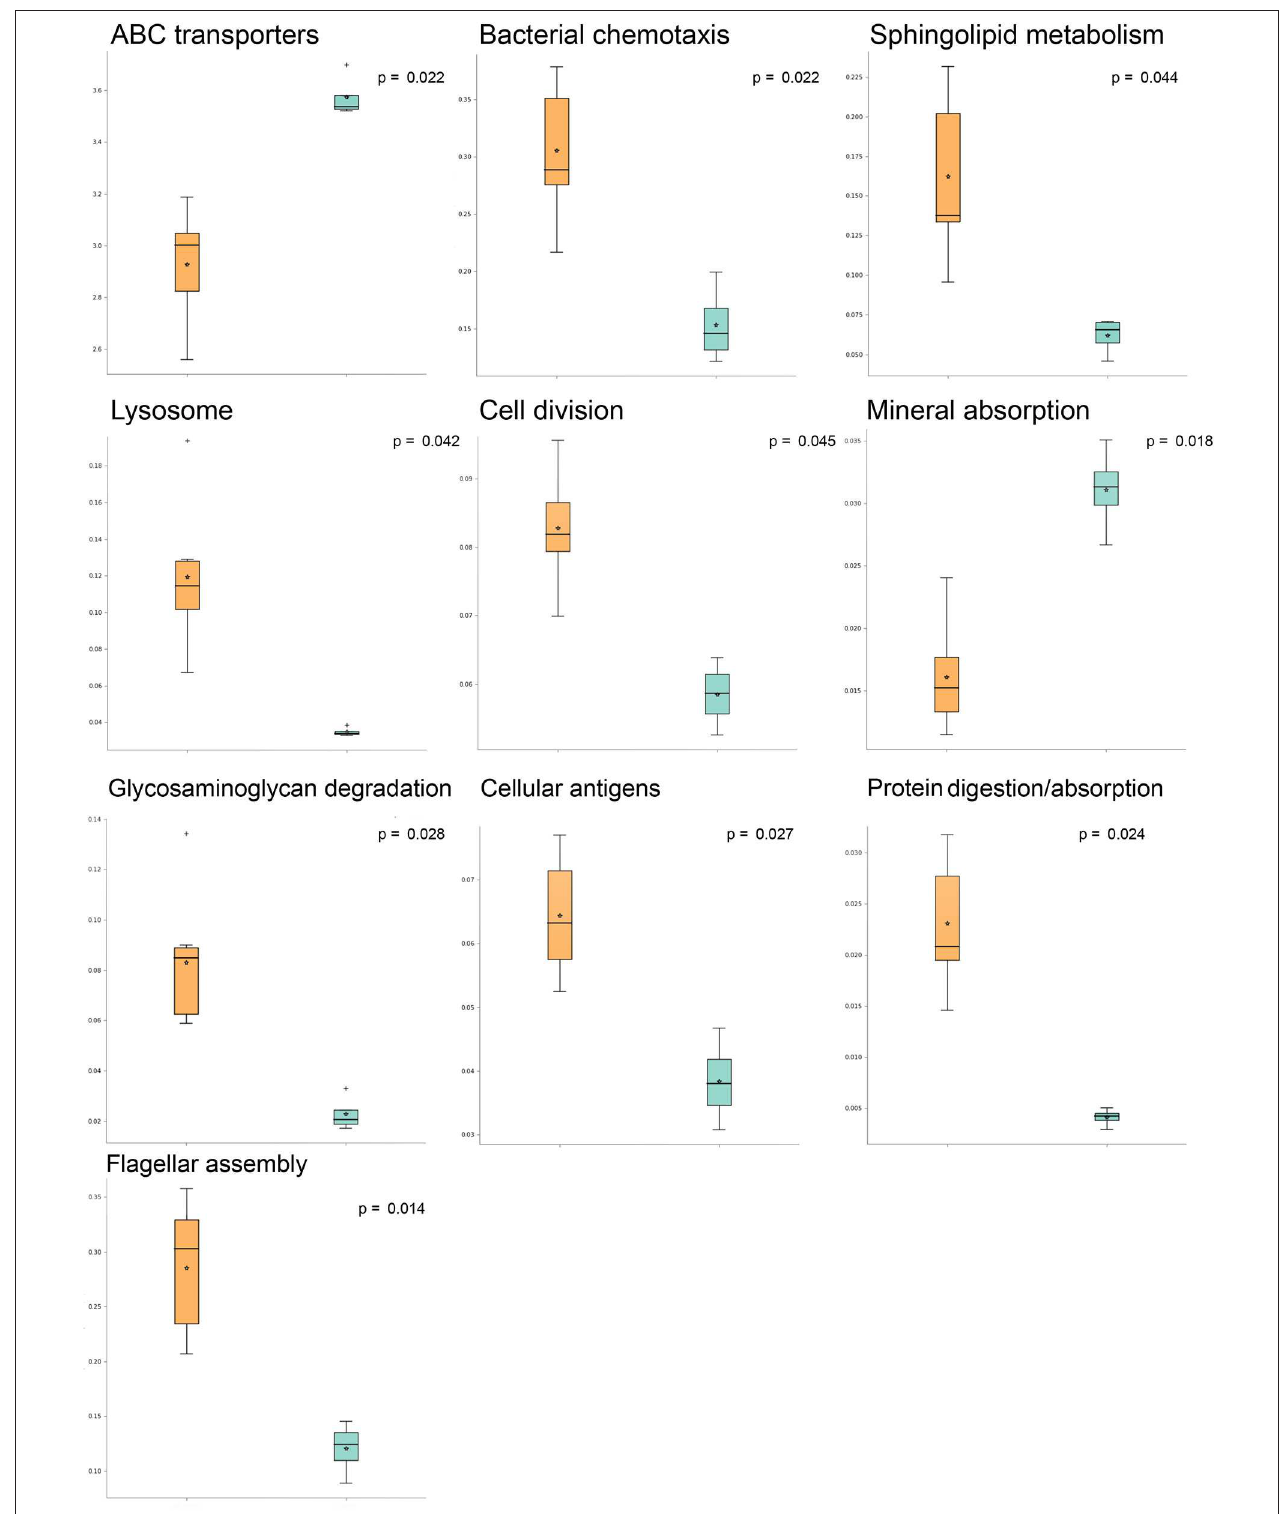
FIGURE 1 | Significantly different pathways in alopecia areata (AA) vs. expression in healthy samples analyzed with STAMP (statistical analysis of taxonomic and functional profiles). Boxplots indicating pathway sample distribution (proportion of sequences) in AA (orange) and healthy (light blue) groups. Only statistically significant pathways are